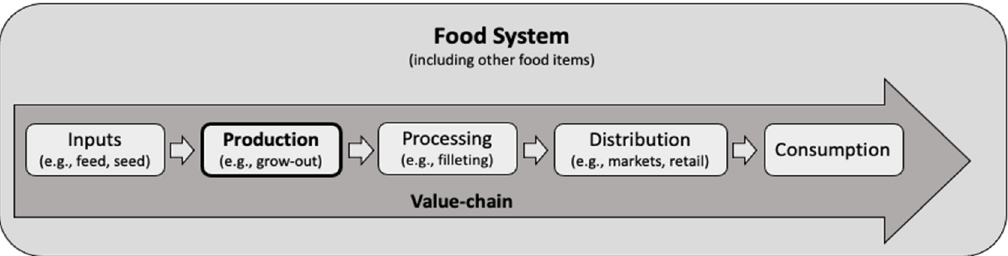
Figure 1. Aquatic animal production is a node within a value chain and broader food